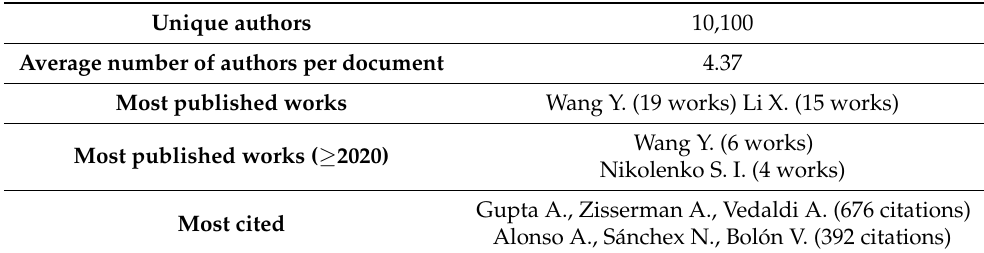
Table 2. Authors’ summary